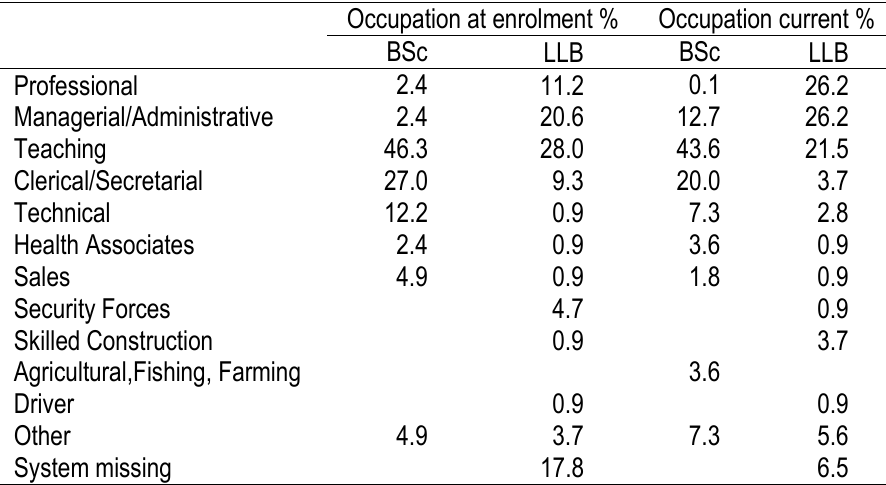
Table 3. Occupation at Enrolment and Current Occupation at enrolment % Occupation current